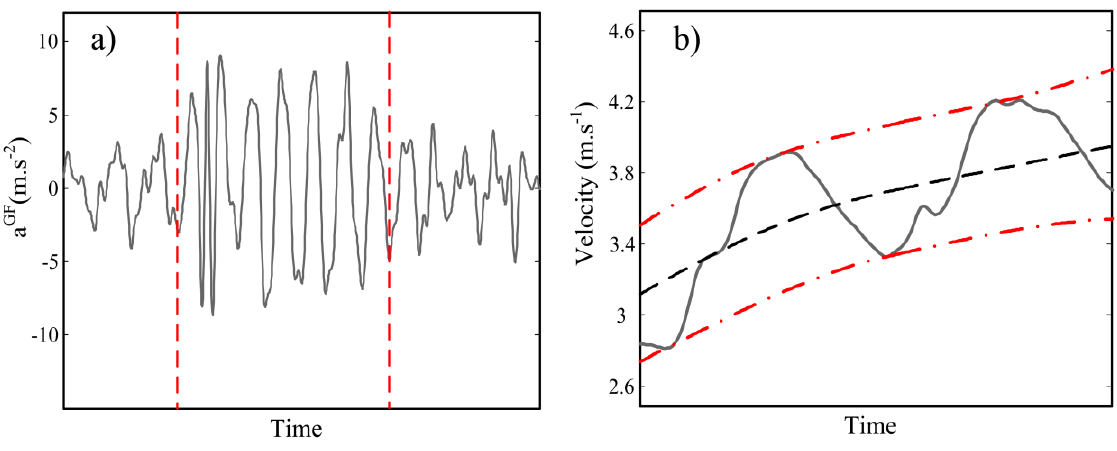
Figure 3. Intermediate steps of velocity profile calculation ( a ) Geometric moving average (GMA) change detection on forward acceleration variance. The acceleration signal is segmented in three parts and correction is applied separately to each part. ( b ) Spline fitting on upper and lower peaks of the first segment acceleration (dash-dot lines) and velocity drift pattern (dashed